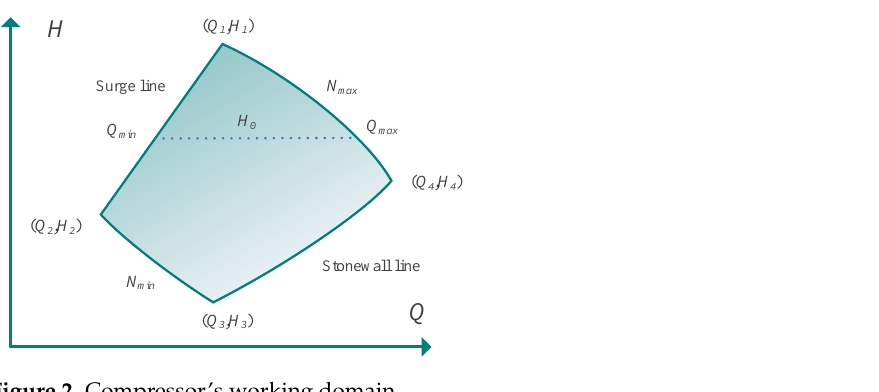
Figure 2. Compressor’s working